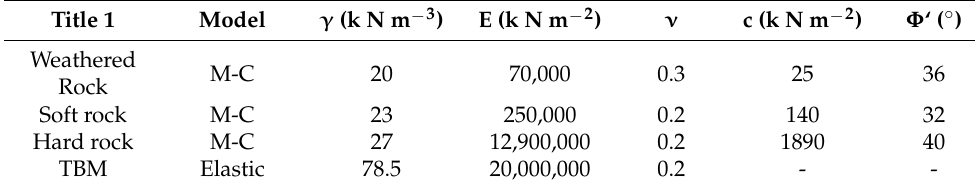
Table 6. Physical properties of the ground and TBM